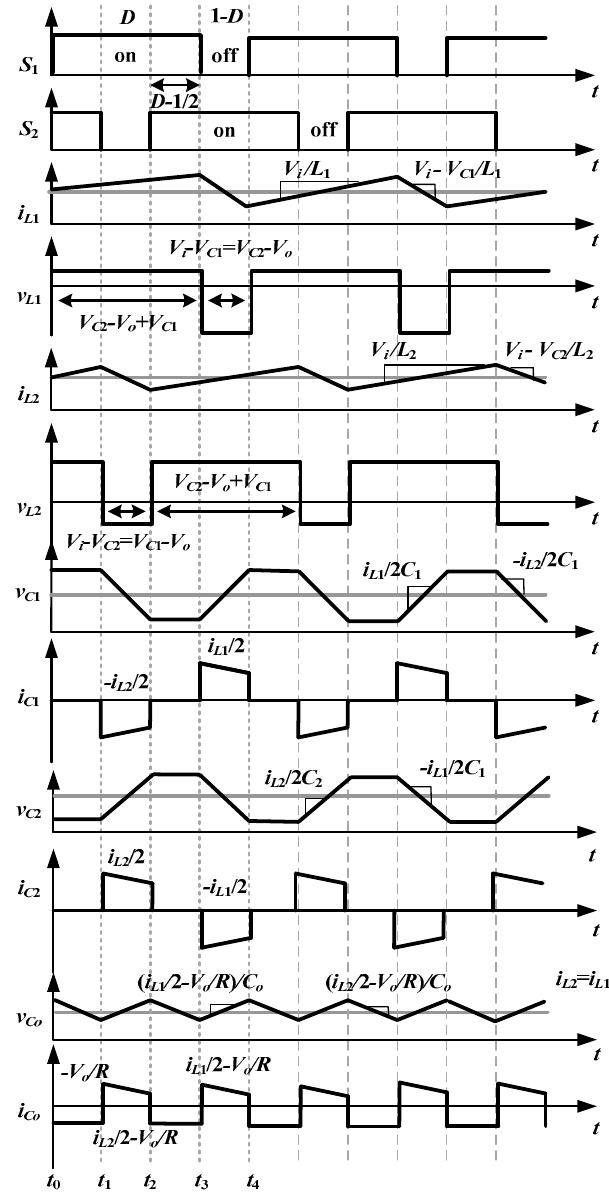
Figure 4. Depicted steady-state waveforms of the combined boost converter.